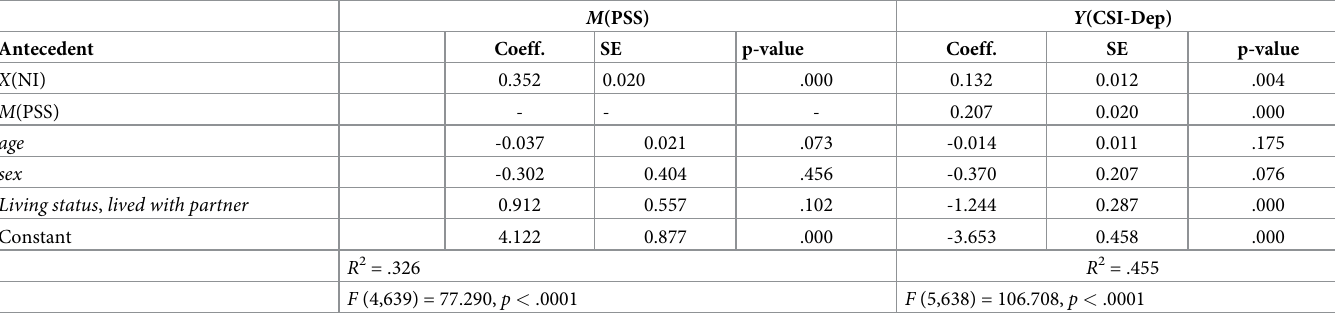
Note: NI = Neuroticism Inventory, CSI–D = Depression scale of Core Symptom Index, PSS = Perceived stress scale, SBI–PP = SBI–PP = Practice precept scale of the inner Strength–based Inventory, SE = standard error.